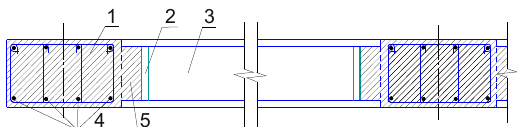
Fig. 1. The joint of the slabs with bearing girders building floor of the ARKOS structural